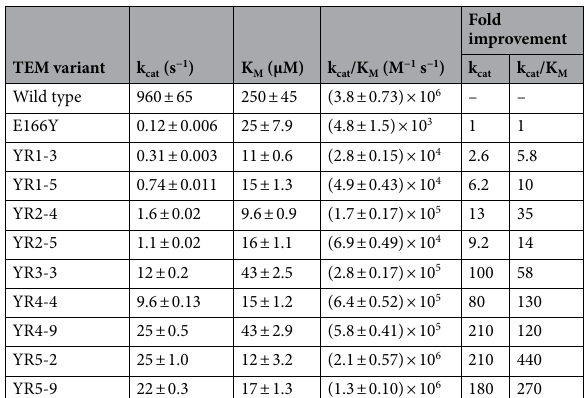
Table 1. The kinetic parameters of TEM variants. The measurements were conducted in 20 mM Tris–HCl pH 7.5 and 50 mM NaCl at 30 °C. The Michaelis–Menten plots of TEM variants are shown in Figure S3. The statistical analysis of the k cat and k cat /K M values are shown in Tables S2 and S3,